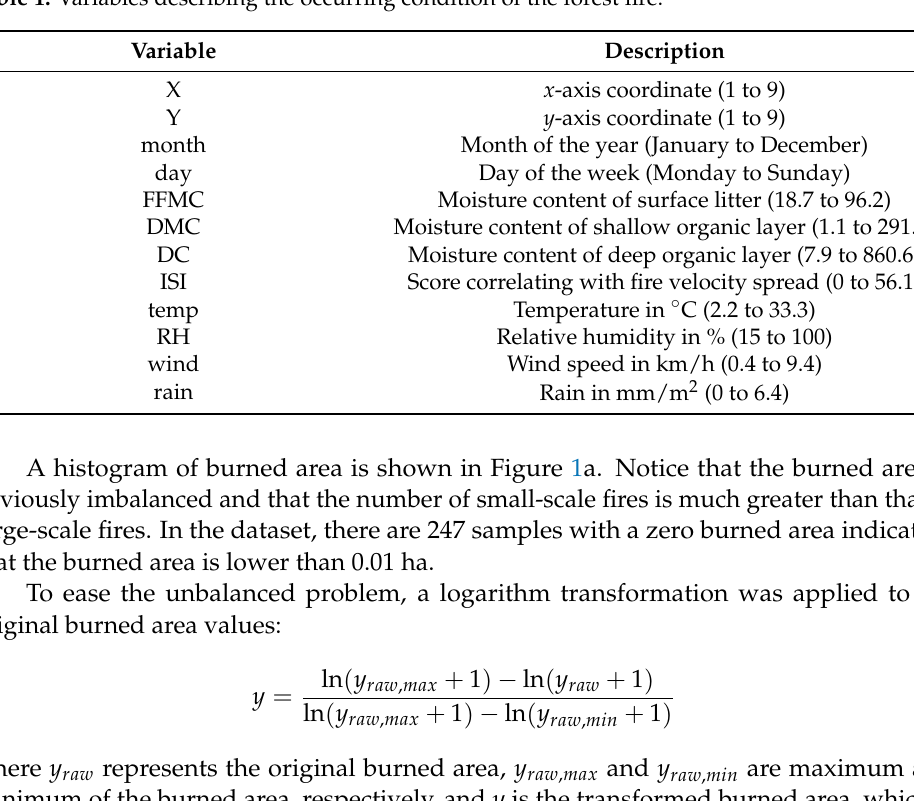
Table 1. Variables describing the occurring condition of the forest